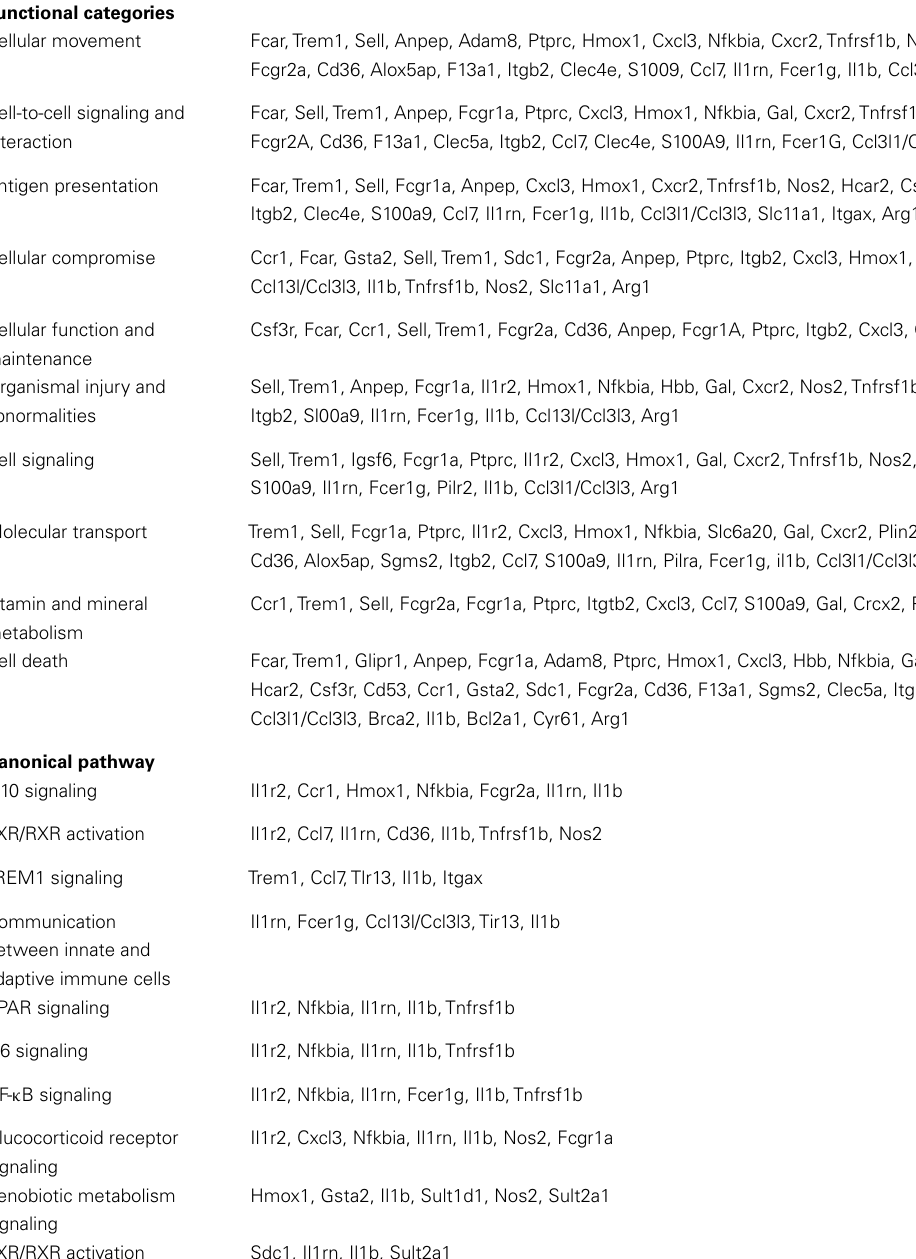
Table 2 | Regulated genes in the functional categories and canonical pathways at 24h